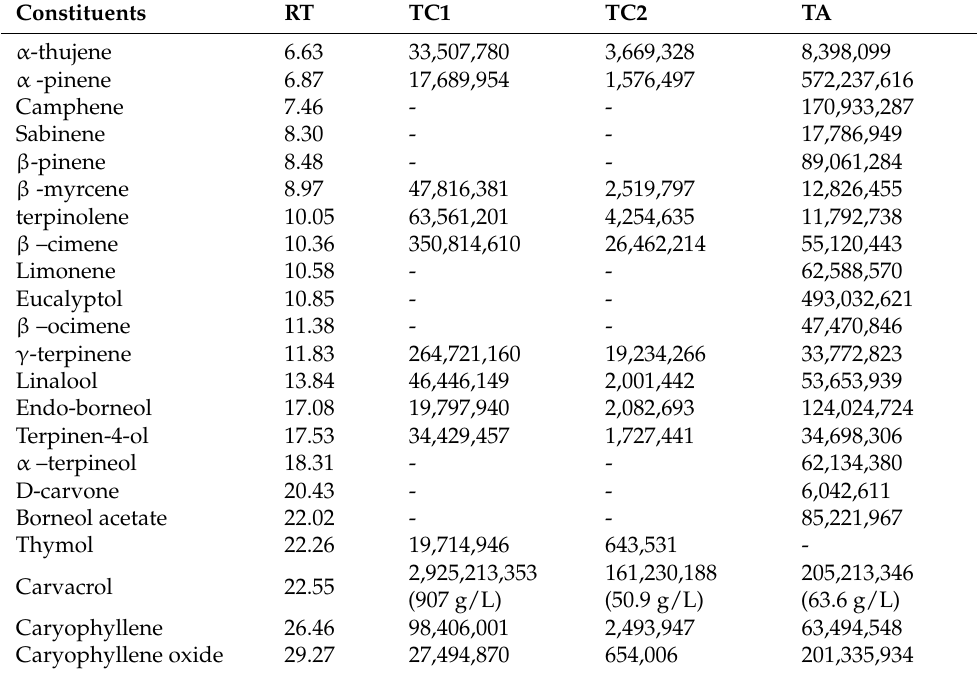
Table 2. Chemical composition of essential oils is reported as the area of the peak of the different compounds, as determined through GC-MS analysis. In the case of carvacrol, also the concentration is reported, through comparison with a carvacrol standard.